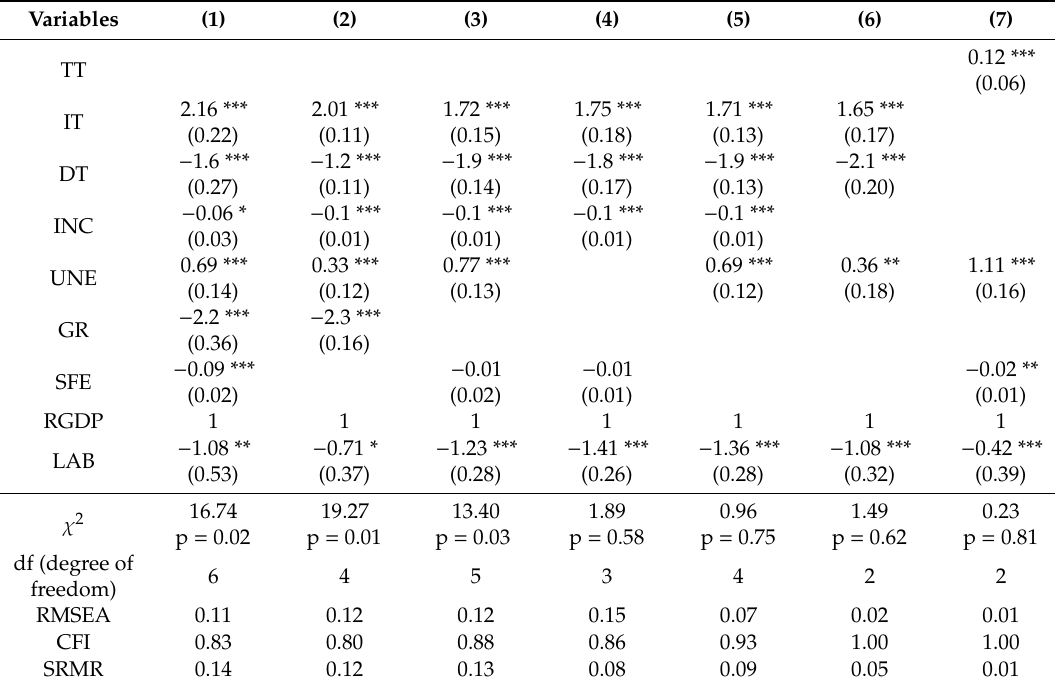
Table 1. Estimation results of the MIMIC